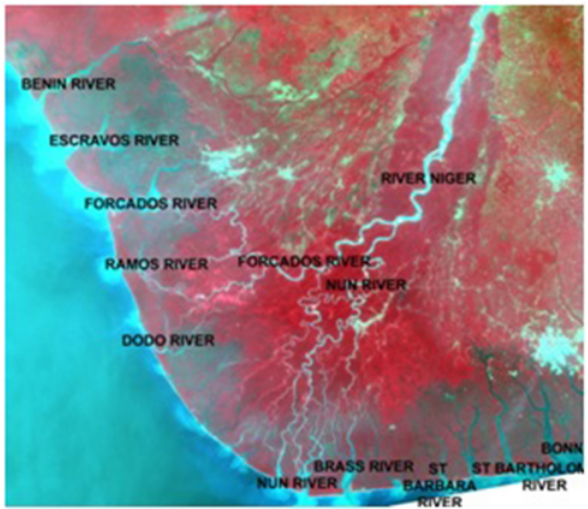
Figure 2. Classified NigeriaSat-1 image of the Niger delta showing five feature